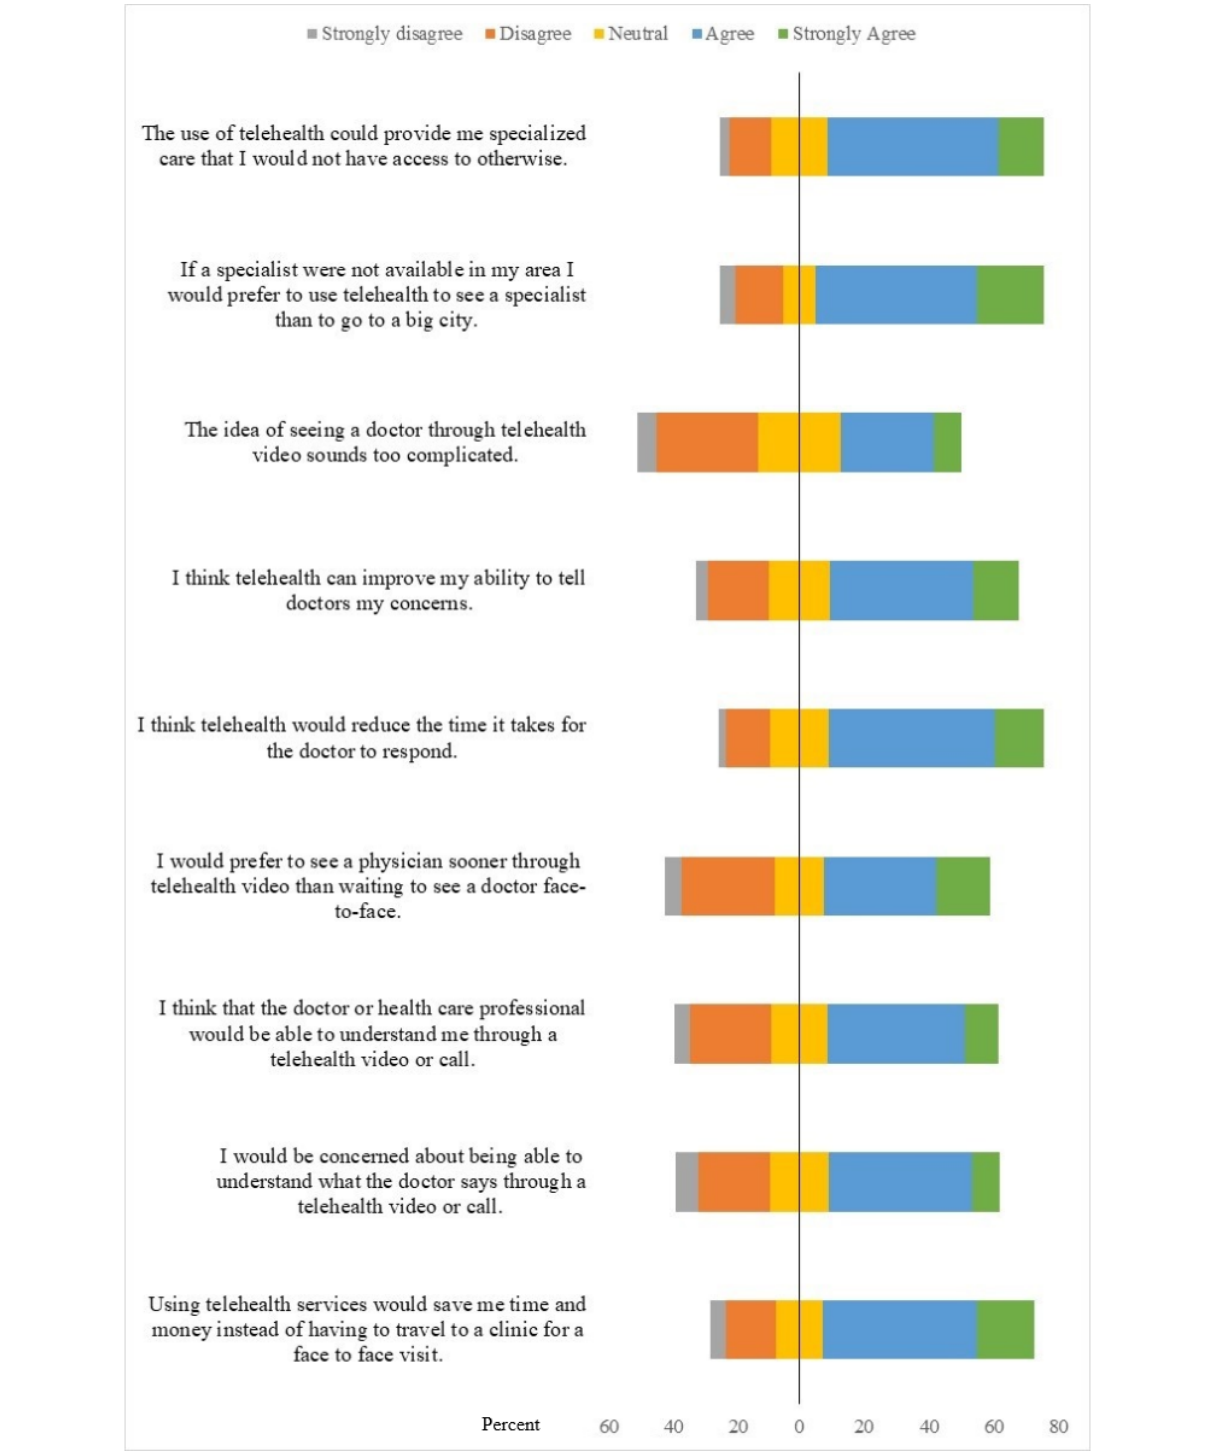
Figure 2. Participant responses to attitudinal statements related to telehealth